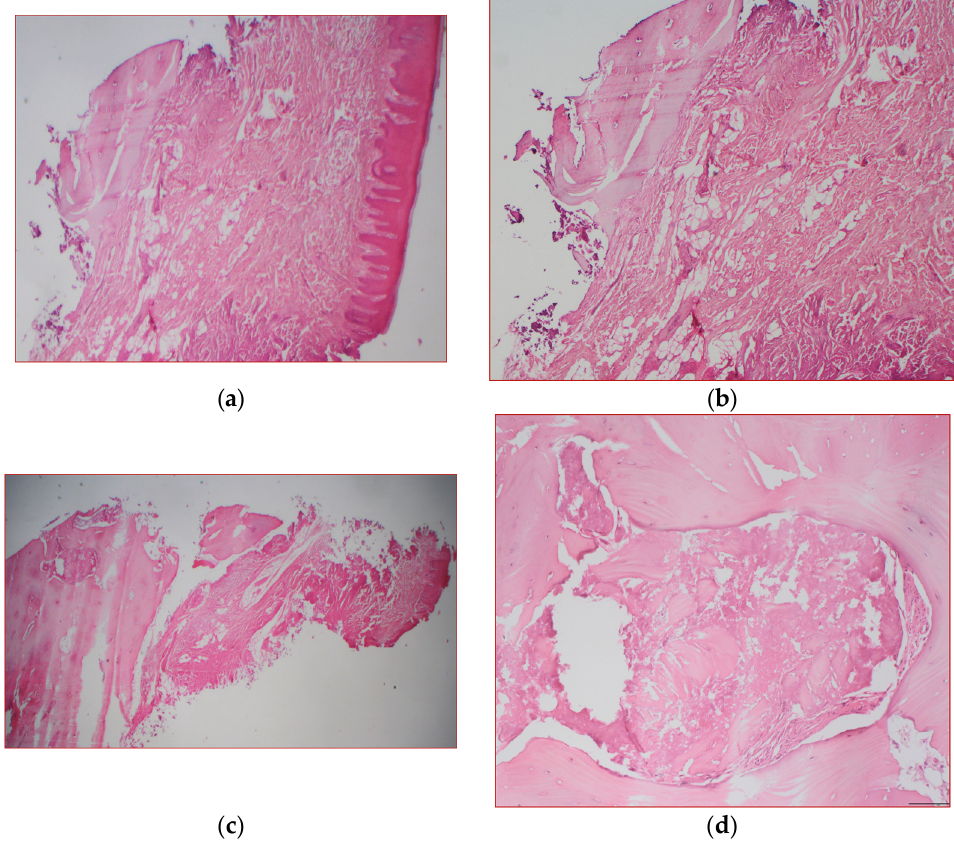
Figure 7. Oral cavity biopsy from the left superior jaw: ( a ) H&E stain of the specimen showing the mucosa with hyperkeratosis and a fragment of the compacted bone with microcalcification around the bone tissue; ( b ) H&E stain 25×. At the bottom ( c ), a second fragment of the same biopsy showed the bone tissue with lacunar necrosis (12×); (d) higher magnification 100×. The final diagnosis of idiopathic osteosclerosis was confirmed. A six-month follow-up showed good healing, and prosthesis on dental implants was performed (Figures 8–10).